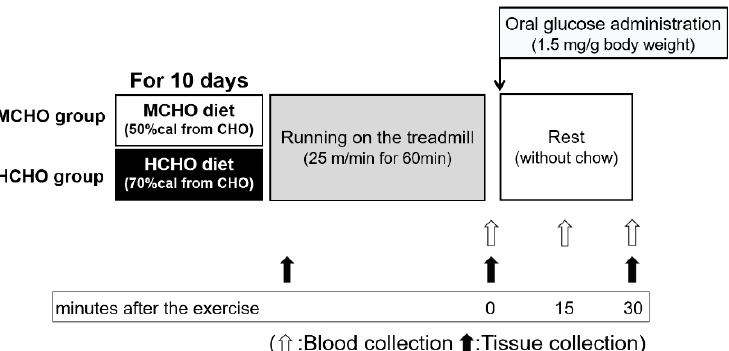
Figure 1. The design of Experiment 1. Eight-week-old male ICR mice were separated into two groups: those fed a high-carbohydrate diet (70%cal from carbohydrate, HCHO) group and those fed a moderate-carbohydrate diet (50%cal from carbohydrate, MCHO) group. After consuming these diets for 10 days, the mice ran on a treadmill at 25 m/min for 60 min in a fed state. Tissues were harvested at the sedentary state, immediately after the exercise, and 30 min after the post-exercise oral administration of glucose (1.5 mg/g of body weight). The experimental diet was removed at 60 min before running to avoid a postprandial state, and the diet was not provided during the post- exercise phase. Blood was collected from a tail vein immediately after the exercise (before the glu- cose administration) and at 15 and 30 min after the post-exercise oral glucose administration.